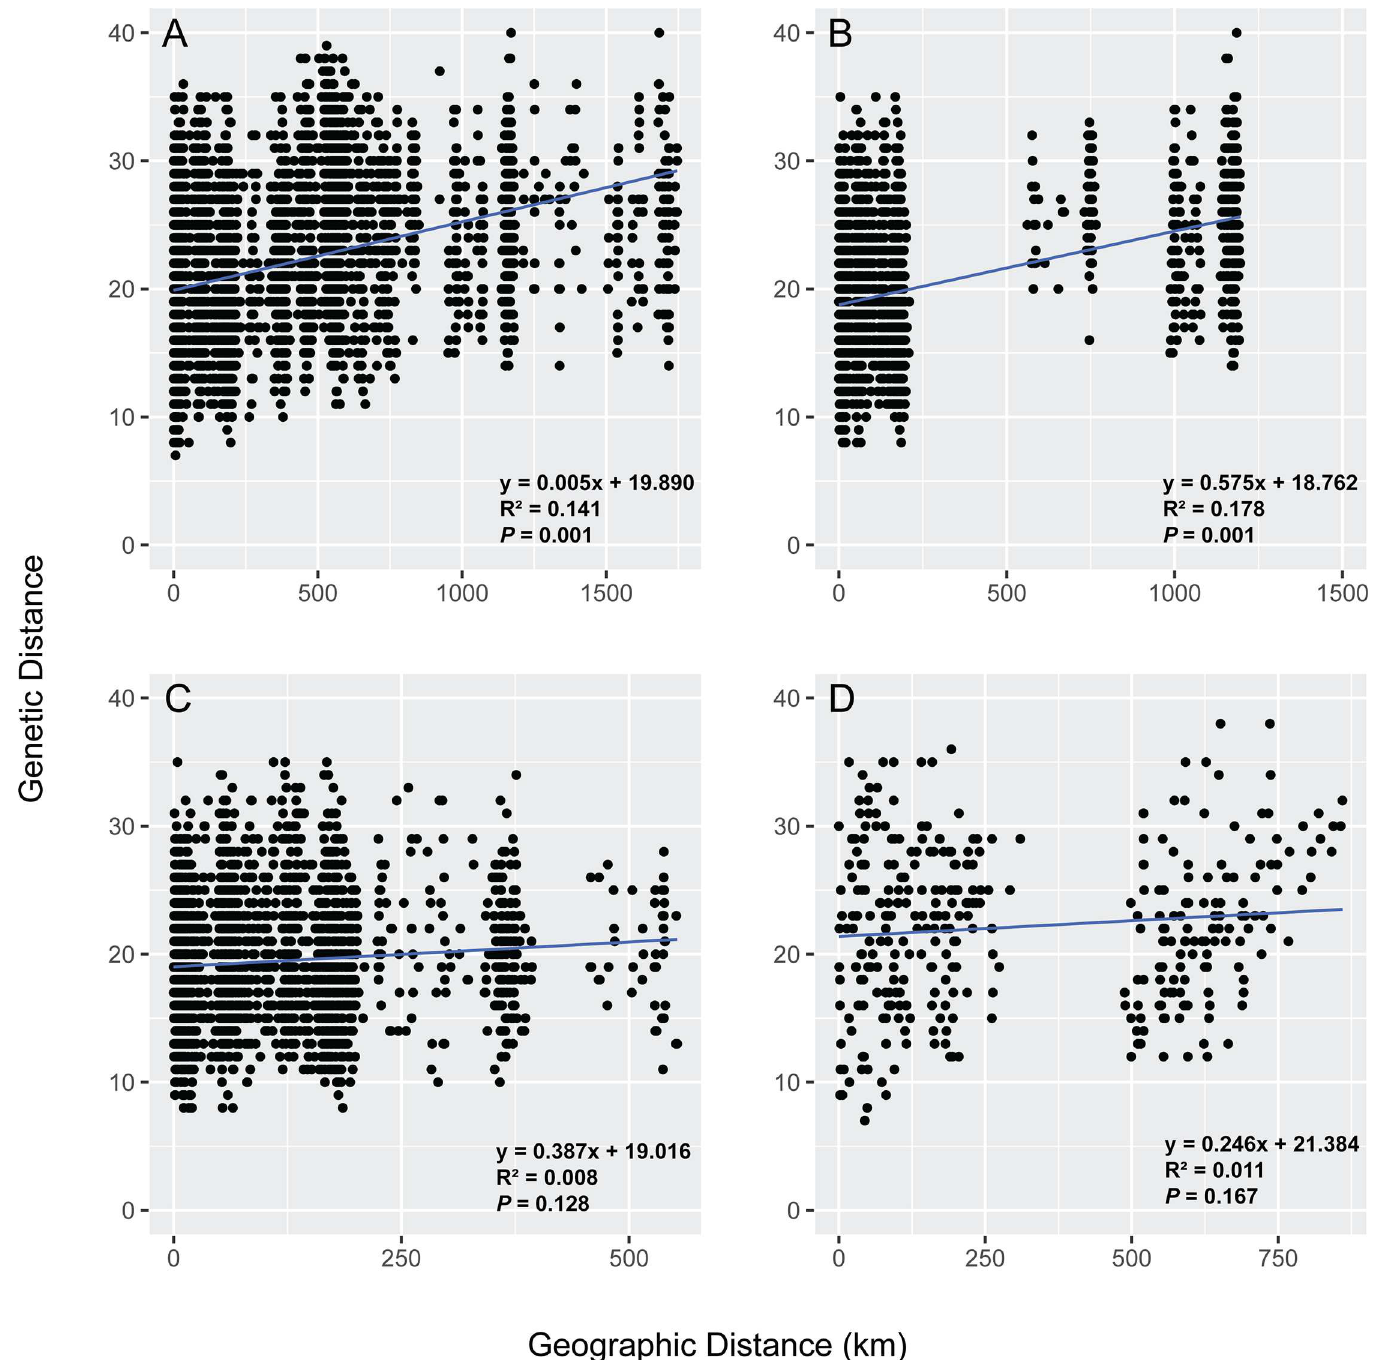
Fig 6. Regional and fine-scale isolation-by-distance patterns in Mesoamerican jaguars. Isolation-by-distance in Mesoamerican jaguars was assessed by plotting pairwise codominantgenotypicdistance calculatedin GenAlEx, version 6.41 [39] versus pairwise Euclidean distances (km) across (A) all samplingsites, (B) Mexico, Guatemala, and Belize, (C) Guatemala, Belize, and Honduras,and (D) Hondurasand Costa Rica. Statistical significancewas assessed using simple Mantel tests in ecodist , version 1.2.9 [62] in R, version 3.1.3 [41]. Each point represents a pairwise comparison among individual